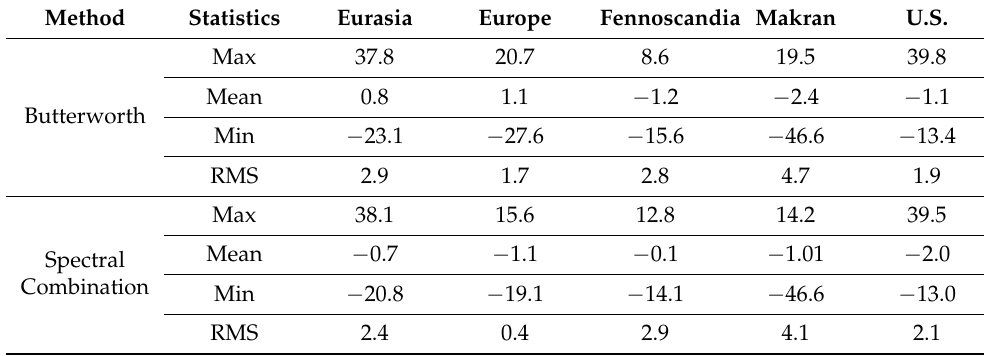
Table 2. Statistics of the Moho depth differences between the HRCM solutions and the continental and regional Moho depth models [5,29–32]. Unit: km.